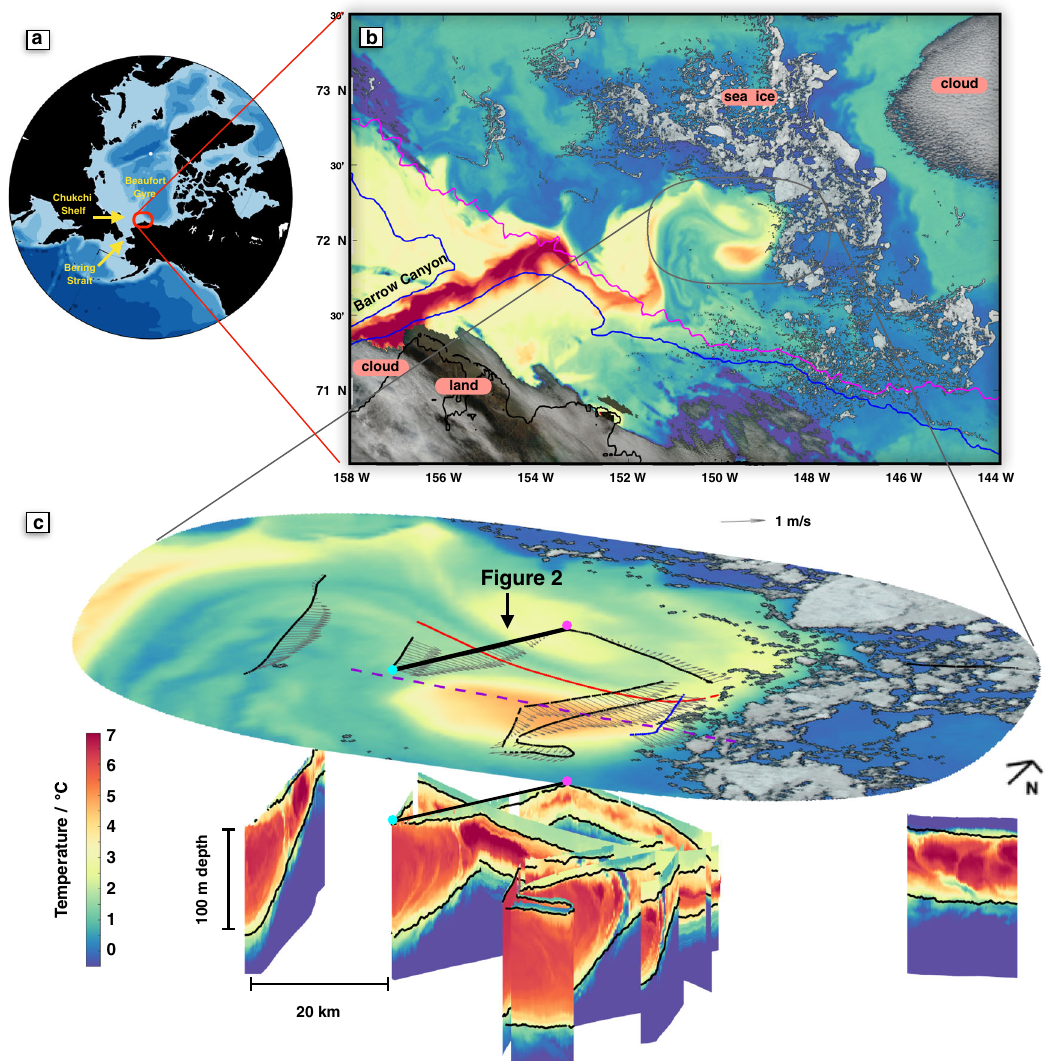
Fig. 1 Overview of warm jet observations. a Red square shows the location of the subsequent panel in the Pan-Arctic context. b Hybrid MODIS satellite image from 15 Sept 2018 showing sea ice and clouds in true color, and sea surface temperature (SST) over open water. The black line is the Alaskan coast, and colored lines are the 100 m (blue) and 1000 m (magenta) isobaths. c Expanded view of part of the satellite image (above) and sub-surface temperature measurements taken 14 – 17 Sept 2018 from multiple instruments (below). Pathways for FastCTD (black line), Wirewalker (red), and Microstructure pro fi ling (blue) are shown on the surface image, as are observed ocean currents (vectors) averaged over the top 90 m, scale arrow to the right. The pathway of the second FastCTD survey 9 days later is shown with a dashed purple line. For the sub-surface temperature data, the 23.2 and 25.2 kg m − 3 potential density surfaces are contoured in black. Surface images and sub-surface measurements share a common temperature scale at lower left. The location of the section shown in detail in Fig. 2 is indicated in c here with a thicker black line and magenta/cyan dots on the northern/ southern